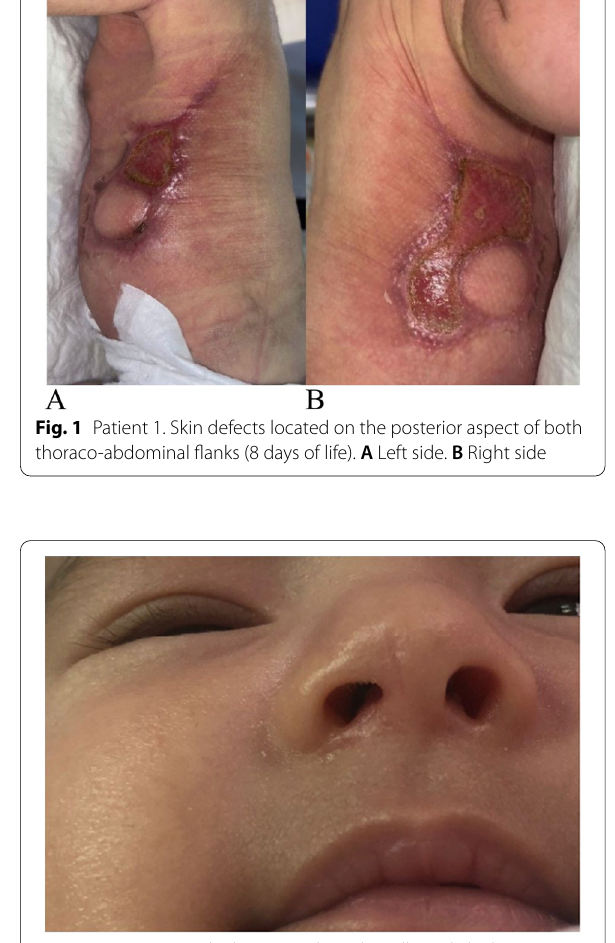
Fig. 2 Patient 2. Residual scars on the columella and alar base, resulting in minimal stenosis of the right